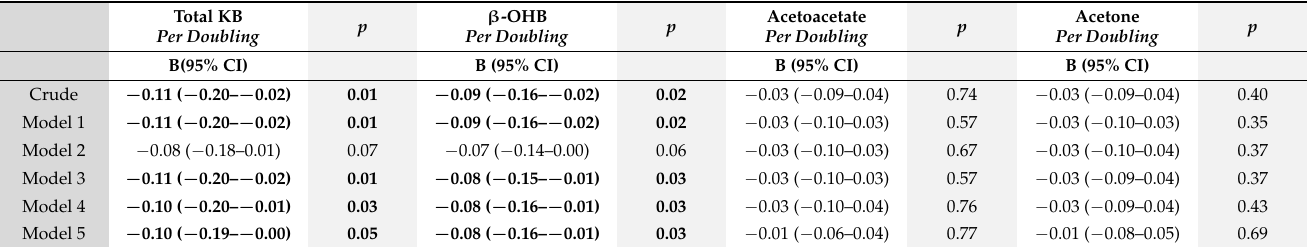
Table 3. Longitudinal associations between fasting plasma KB and annual HbA1c (%) change over time in linear mixed model analyses in ZODIAC.